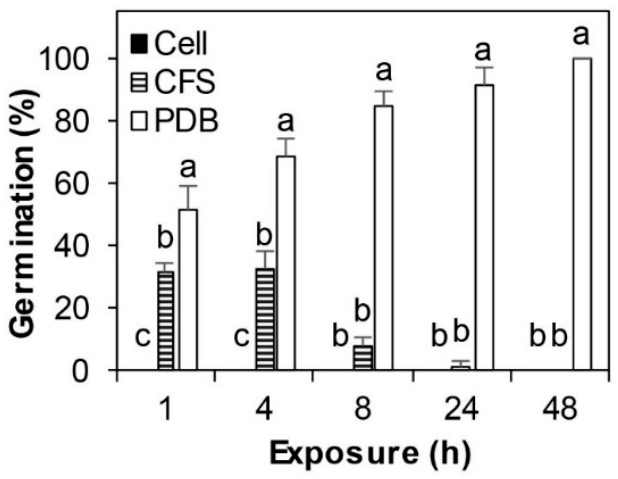
Figure 1. Conidia germination of Calonectria pseudonaviculata after being incubated in small sage green (SSG) cell suspension at 10 7 cfu / mL (Cell), cell-free supernatant (CFS), or potato dextrose broth (PDB). Each column is an average of six replicates from two repeated assays and is topped by a standard error bar. Columns marked with the same letter within each exposure time did not di ff er according to the least significant di ff erence (LSD) test at p = 0.05.